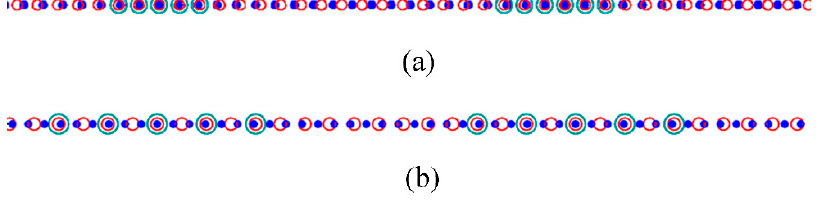
Figure 1. Artificial 1D lattices for illustrating the first step in the near-row-matching method. good matching site (GMS)-row segments (marked by large green circles) formed by overlapping rows of dense lattice points from the two lattices, represented by blue solid circles and red open circles, respectively, showing ( a ) one-to-one and ( b ) two-to-three matching correspondences.